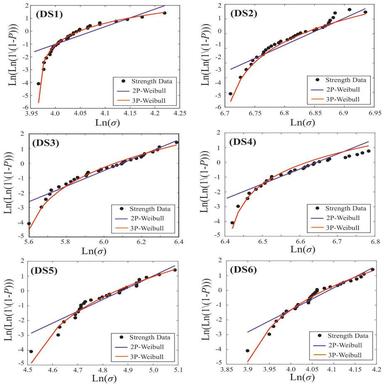
The Weibull plot of experimental strength datasets and their fits with 2P-and 3P-Weibull distribution functions.